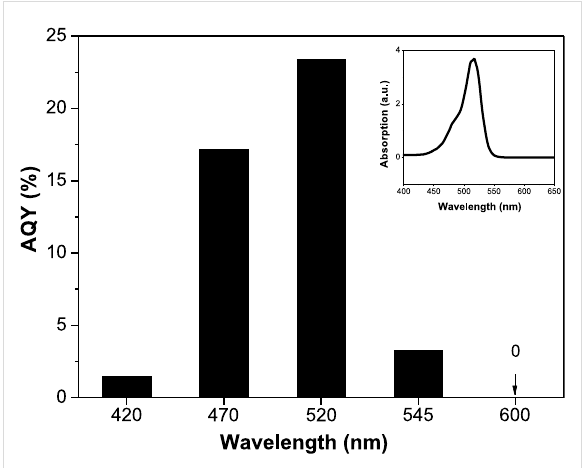
Figure 8: AQY of the EY-RGO24/Pt photocatalyst plotted as a func- tion of the wavelength of the incident light. Conditions: 10 μ g mL − 1 RGO24; 5.0 × 10 − 4 mol L − 1 EY; 4.6 × 10 − 6 mol L − 1 H 2 PtCl 6 ; 7.7 × 10 − 2 mol L − 1 TMA, pH 10.0; irradiation 2 h. The inset is the UV–vis absorption spectrum of EY in TMA